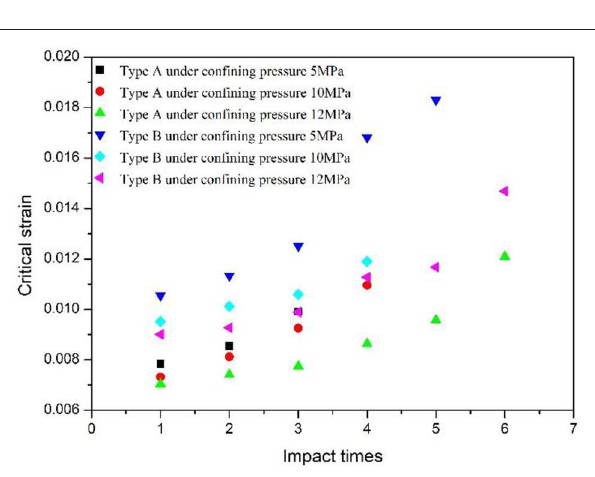
FIGURE 8 | Variation in critical strain with respect to impact times.